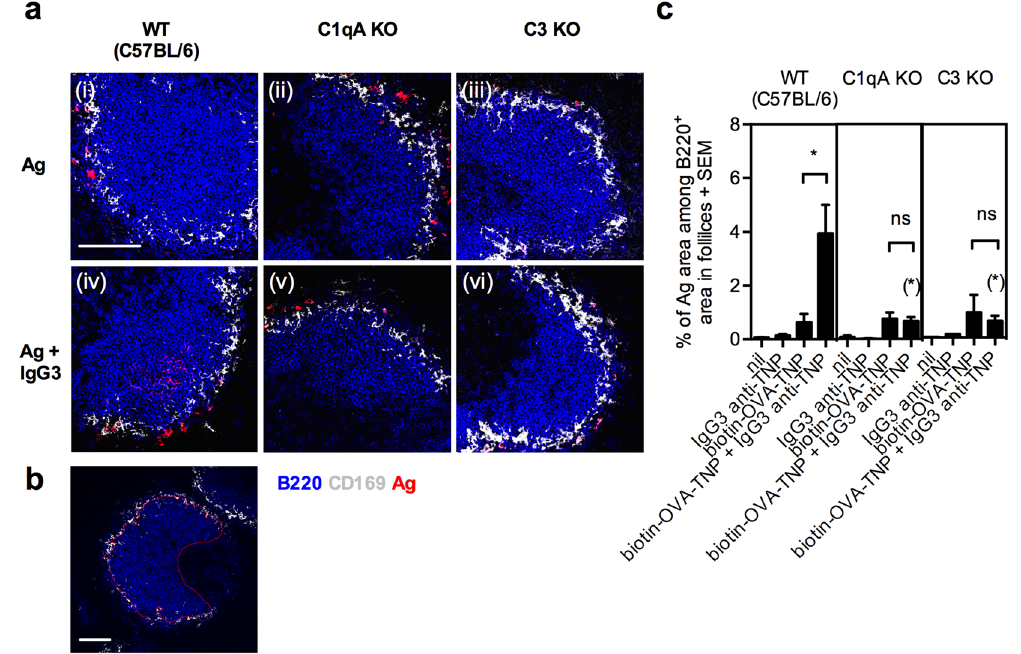
Figure 2. IgG3-mediated localization of antigen to splenic follicles is dependent on C1q and C3. WT (C57BL/6), C1qA KO, and C3 KO mice were immunized as described in the legend to Fig. 1. The other half of each spleen analyzed in flow cytometry (Fig. 1) was sectioned and stained with a mixture of anti-mouse B220-Pacific Blue (B cells; blue), anti-mouse CD169-FITC (metallophilic macrophages; grey), and SA-APC (antigen; red) for 1 h. One longitudinal section of each half spleen was analyzed by confocal microscopy. ( a ) Representative FO areas (313 μ m × 313 μ m, scale bar = 100 μ m) of 4–5 follicles per mouse from each group. ( b ) The red line shows how the border of the follicle against the MZ and the T zone was defined (640 μ m × 640 μ m, scale bar = 100 μ m). ( c ) Quantification of antigen concentration in the B cell follicles with borders as defined in ( b ). Data are representative of three independent experiments (two with IgG3 clone IM-F10 and one with IM-H11) and are shown as mean + SEM. The p values for comparisons of the responses in mice immunized with antigen alone or IgG3-antigen complexes are indicated without parentheses. The p values for comparisons of responses in WT versus C1qA or C3 KO mice immunized with IgG3-antigen complexes are indicated within parentheses. ns, p > 0.05; * p <